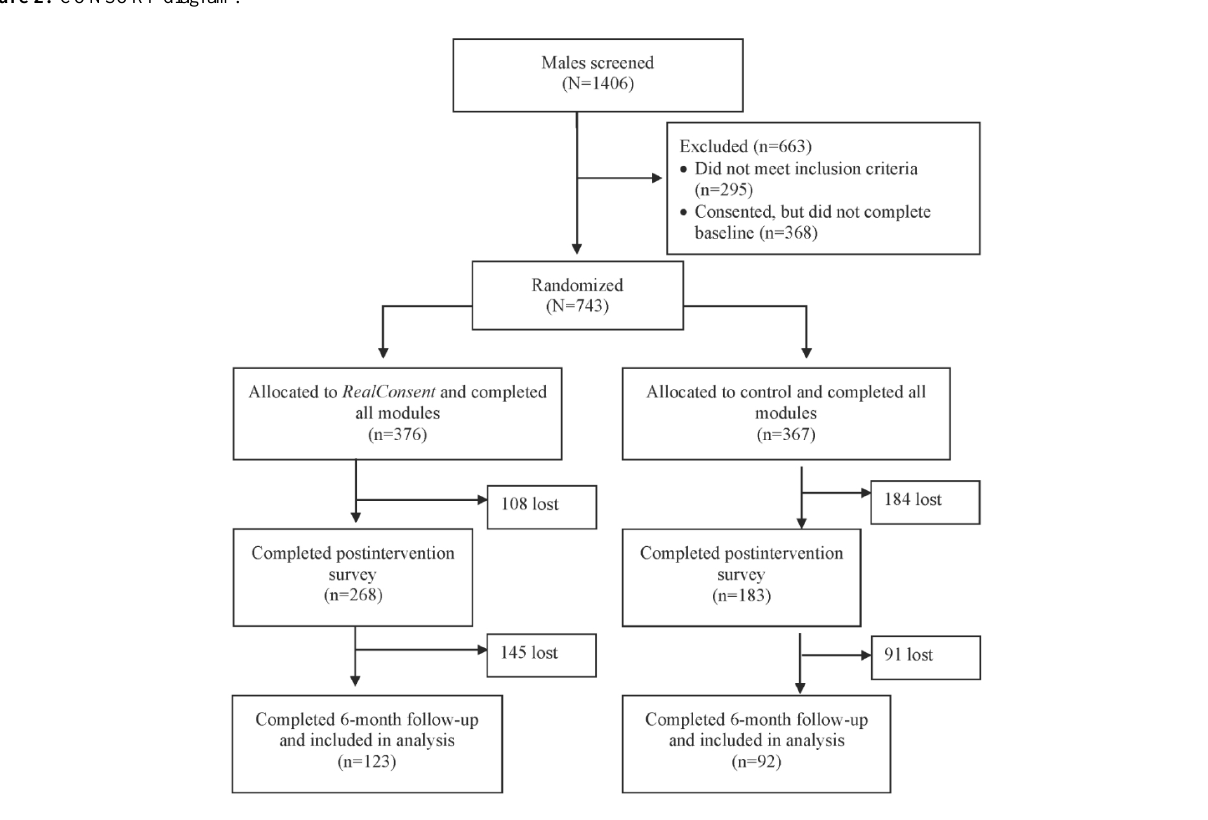
Figure 2. CONSORT